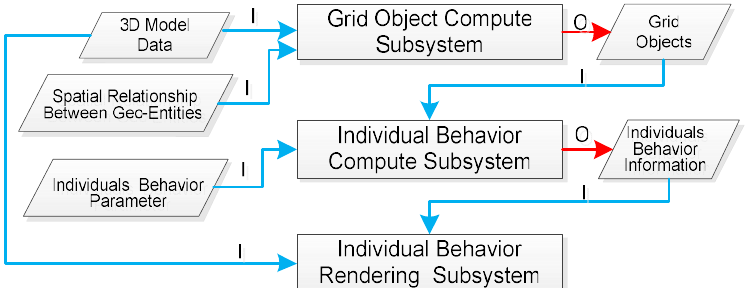
Figure 5. The architecture of the individual behavior simulation prototype system developed using the GOAM. The character I and the blue lines represent the data inputs to the subsystems, while the character O and the red lines represents the data outputs of the subsystems.